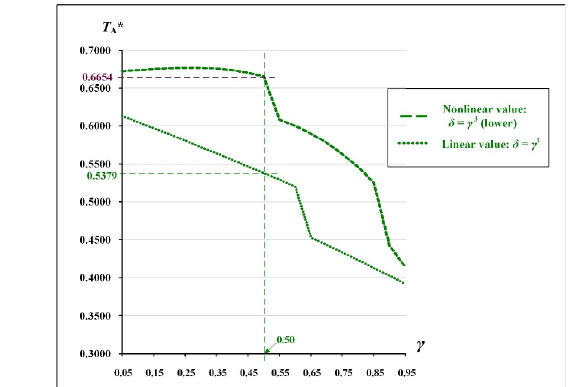
Fig. 11. Behavior of E [ TCU ( T A *, n *)] regarding dissimilar relationships of δ and γ